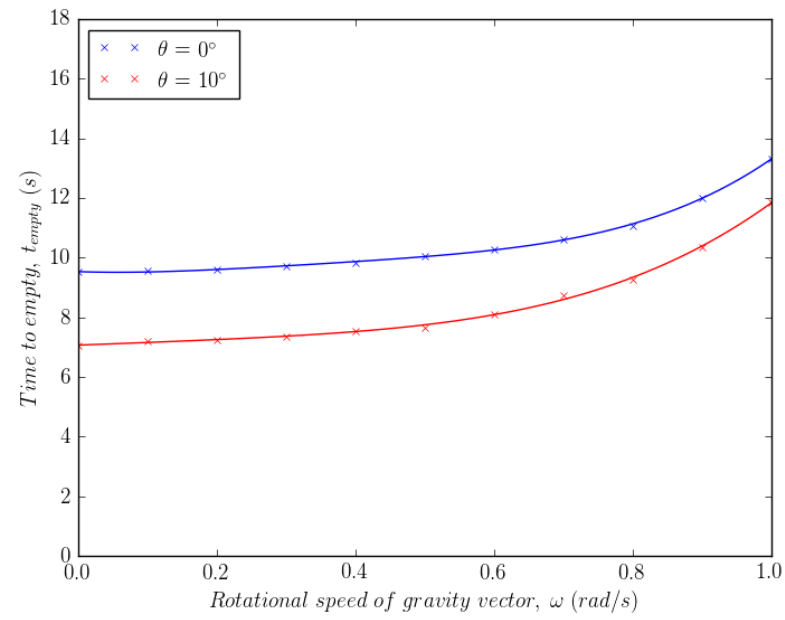
Figure 15. Time to empty versus rotational speed of gravity